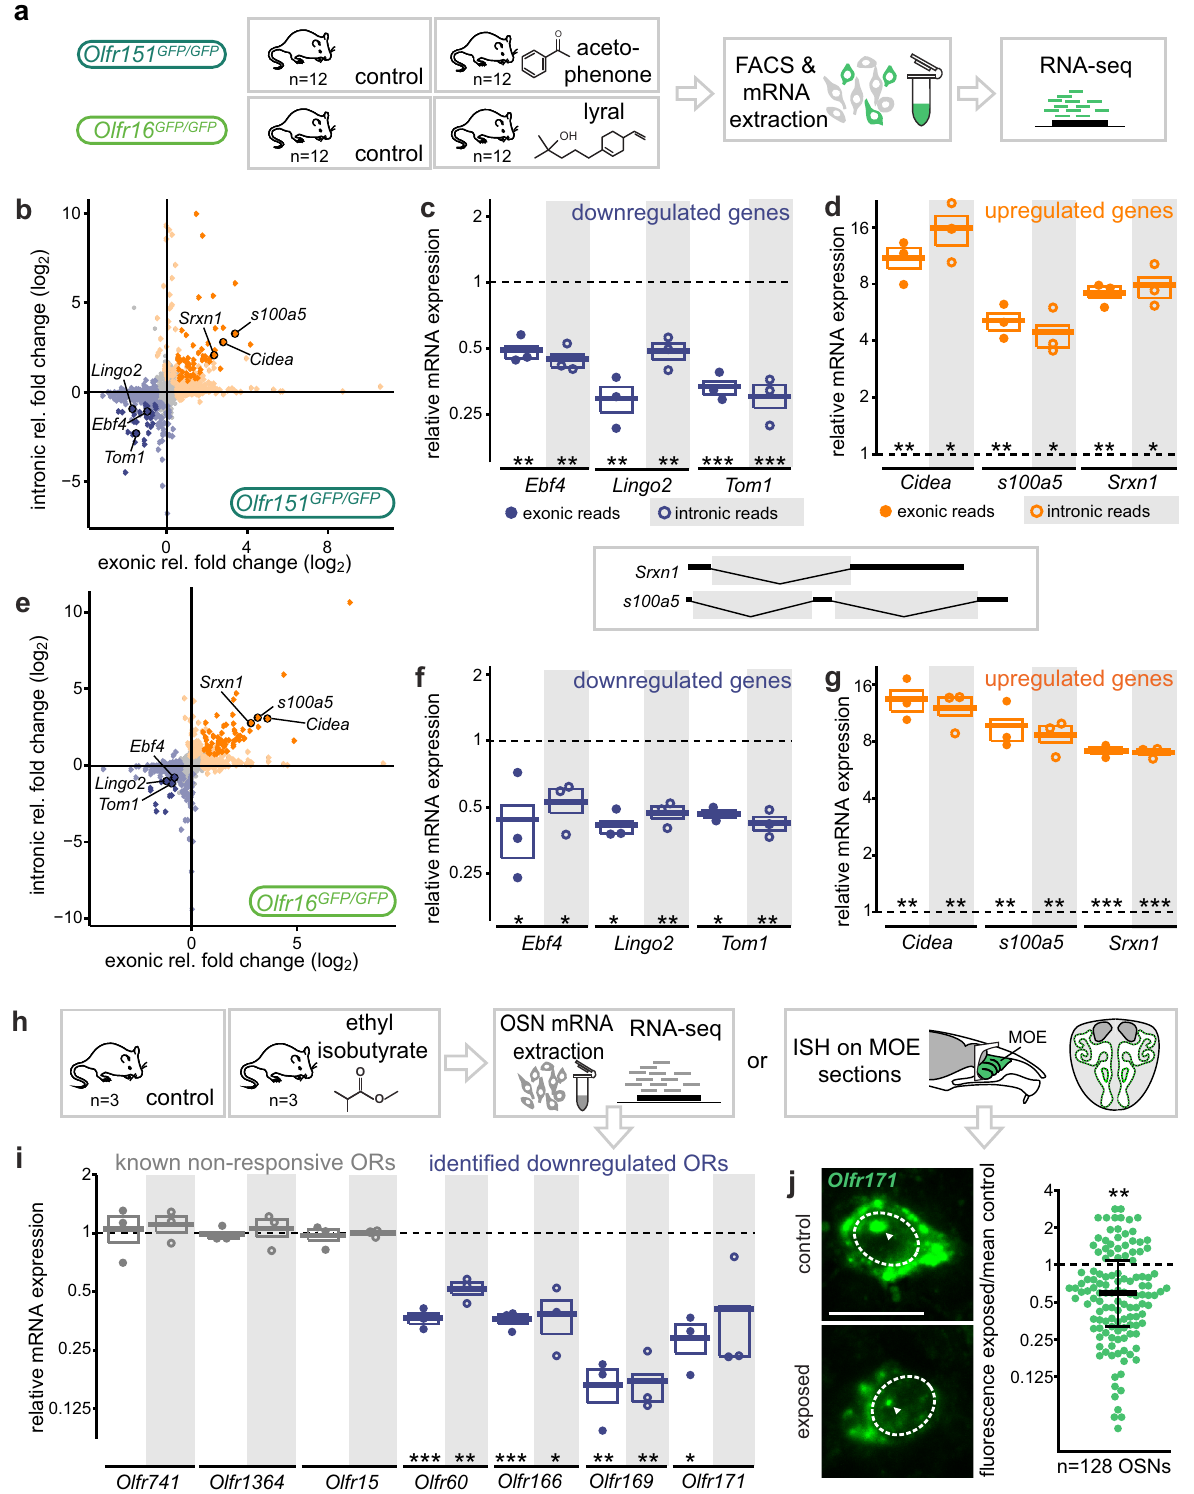
Single-Cell 3 ′ v3.1 protocol (dual index libraries). The cDNA libraries from each musculus GTFannotationwasused.ThisGTF fi lewasupdated withthere-annotation sample were then pooled and loaded at 2nM on 2 lanes of the Illumina HiSeq of the 3 ′ UTR of olfactory receptor genes. The fi ltered feature-barcode matrices were 4000 system for paired-end sequencing. used for downstream analysis. These matrices included a total of 21,809 cells (sample 1: 5364 cells; sample 2: 5696 cells; sample 3: 4756 cells; sample 4: 6004 cells). scRNA-seq mapping and counting . fastq fi les were pre-processed with Cell Ranger version 6.0.1 56 with default settings. Reads were mapped on the Mus musculus gen- scRNA-seq data fi ltering . Single-cell RNA sequencing data analyses were performed on R version 4.0.5 using the Seurat R package version 4.0.1 58,59 . Seurat ’ s functions ome primary assembly reference 38 (GRCm38) using the STAR aligner 57 imple- mented in Cell Ranger. A modi fi ed version of the Ensembl release 102 of the Mus were used with default settings unless speci fi ed. The standard analysis consisted of NATURE COMMUNICATIONS| (2022) 13:2929